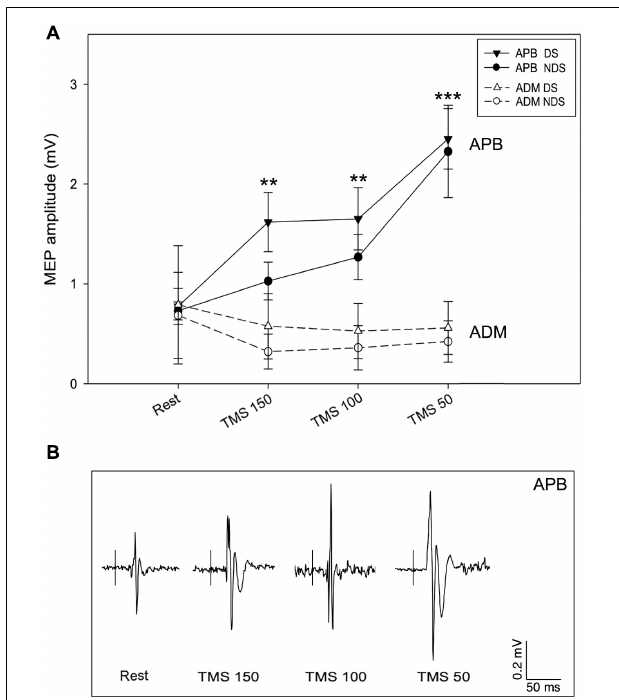
FIGURE 3 | Motor evoked potential amplitude at rest and after TMS. (A) In APB, TMS increases MEP amplitude when delivered 150 (MEP150), 100 (MEP100), and 50 ms (MEP50) before the EMG onset, suggesting the occurrence of premovement facilitation (PMF; note the highest increase of MEP50). No significant changes of MEP amplitude were recorded from ADM, bilaterally. (B) Representative MEPs from APB in the different experimental conditions. Data expressed as mean ± standard deviation (rmANOVA, ** p < 0.05; *** p < 0.001). APB, abductor pollicis brevis; ADM, abductor digiti minimi; MEP, motor evoked potential.